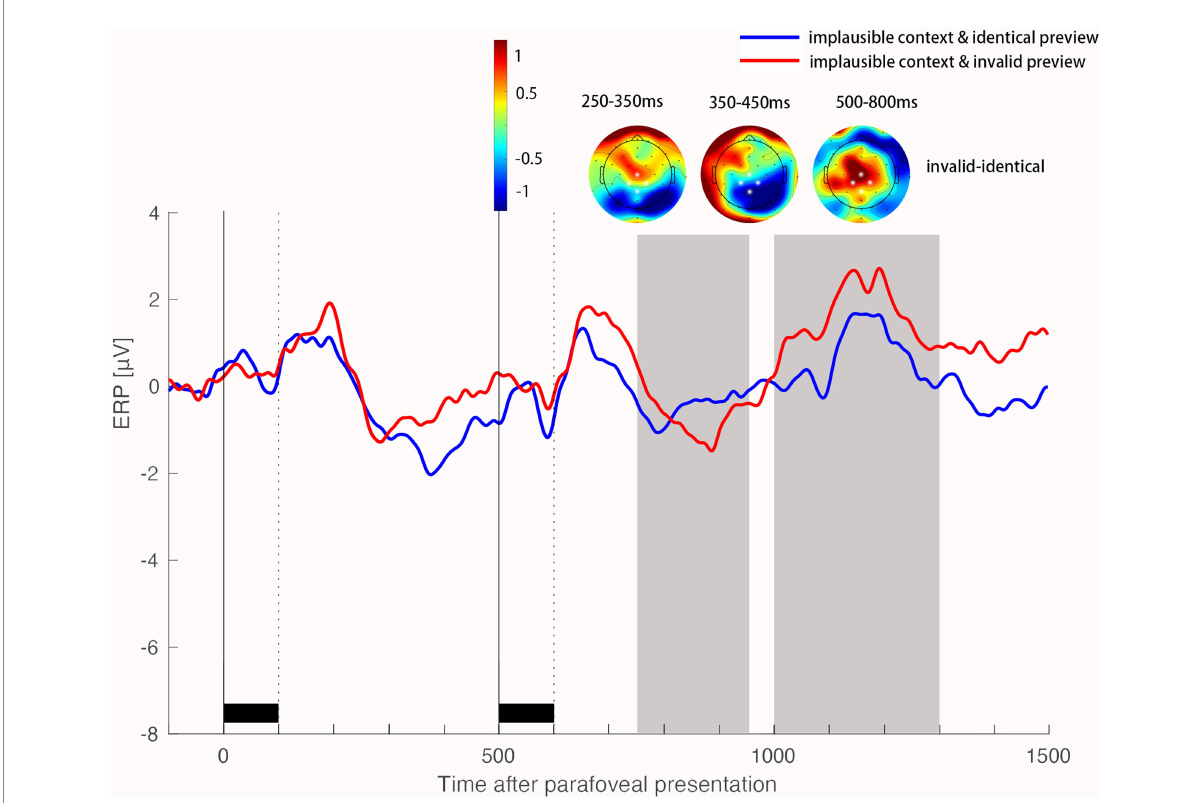
FIGURE 5 Identity preview benefit on the N400 and LPC components when the target word was implausible in the sentence. Time 0 on the time axis marks the onset of the target word in the right parafoveal position. ERP waveforms show the average activity in the ROI of four electrodes (highlighted in white in the topographic map) for the identical preview condition and invalid preview condition. Scalp topographic maps show the difference in ERP activity (invalid preview conditions minus identical preview conditions) in the time window of 250–350 ms, 350–450 ms and 500–800 ms after the onset of the target word in the foveal position,